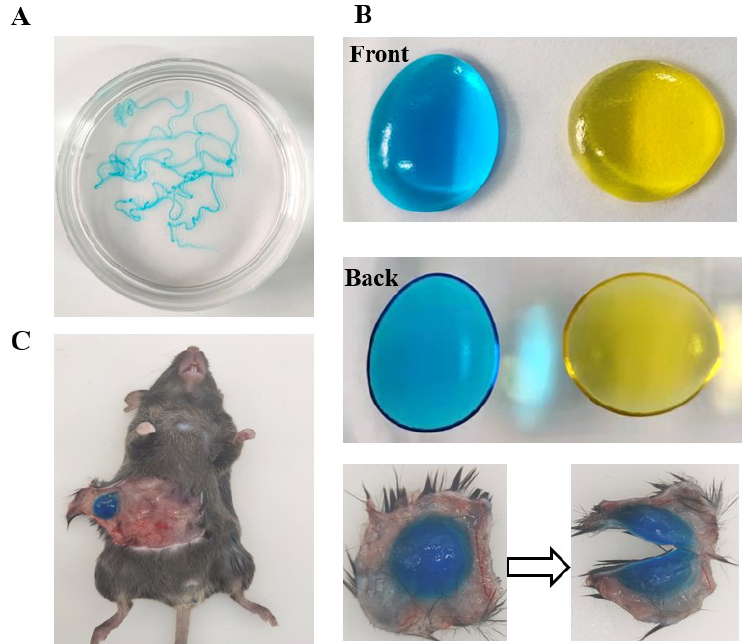
Figure 4. Good syringe ability and molding properties of EDA TSGs. EDA TSGs was injected into ( A ) water of 37 °C, ( B ) air of 37 °C and ( C ) mouse subcutaneous tissue. ( A ) water of 37 ◦ C, ( B ) air of 37 ◦ C and ( C ) mouse subcutaneous